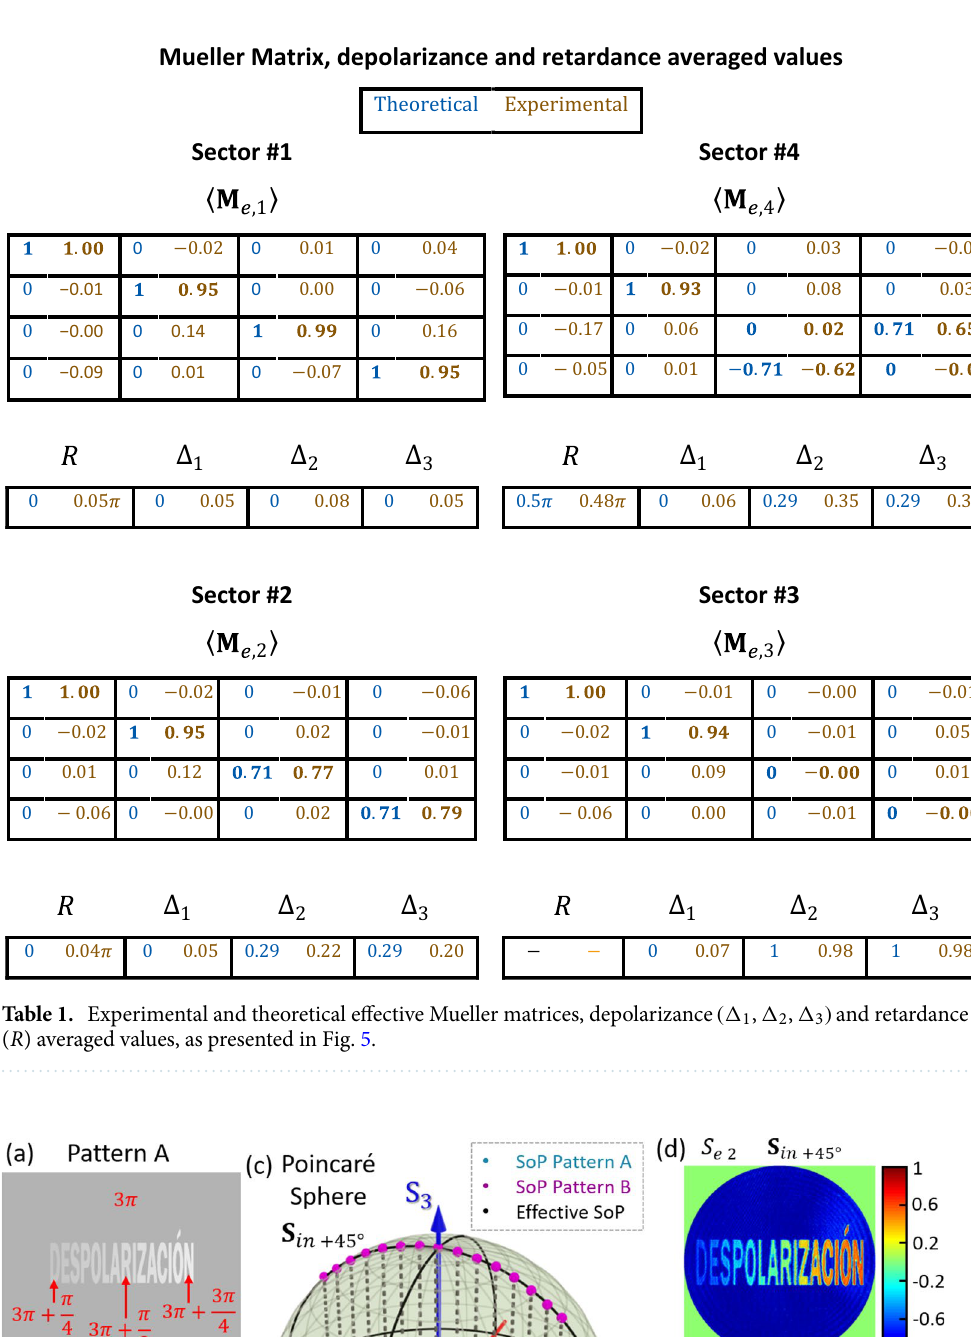
S e (cid:30) (cid:31)